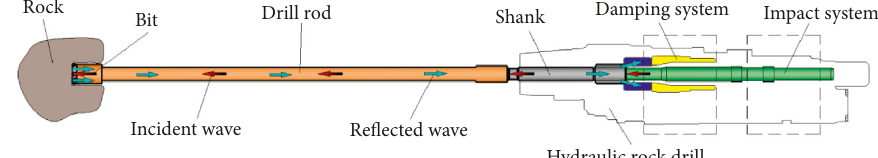
Figure 1: Working principle of hydraulic rock drill.